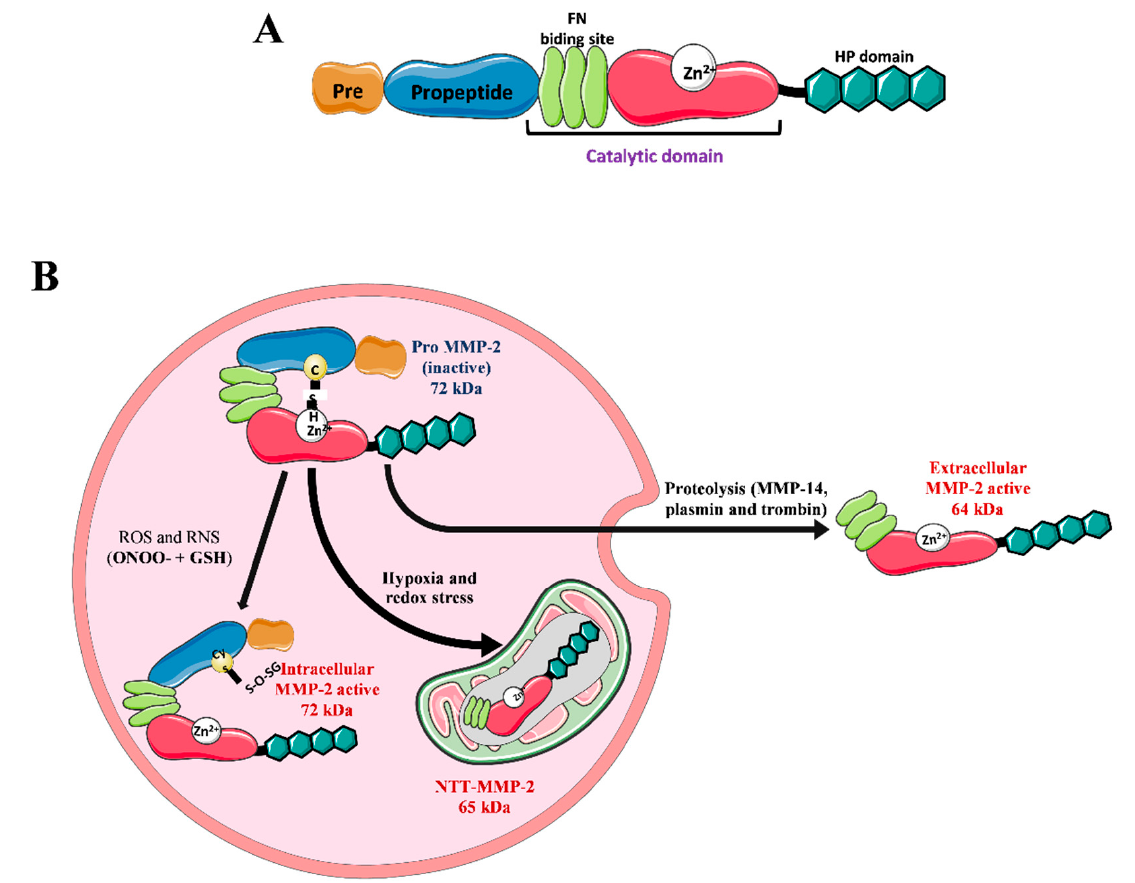
Figure 2. Structure, activation and isoforms of MMP-2. ( A ) MMP-2 has in its structure a signal peptide (Pre), a propeptide (Pro), a catalytic domain (having a zinc ion and three fibronectin repeats that confer affinity to collagen) and hemopexin (HP). ( B ) The inactive isoform of MMP-2 has a molecular size of 72 kDa (pro-MMP-2). Inactivity is guaranteed by a cysteine residue in the propeptide domain, which binds to Zn 2+ in the catalytic domain, preventing the binding and proteolysis of substrates. The active intracellular isoform of MMP-2 has a molecular size of 72 kDa and occurs when ONOO − or GSH reacts with ONOO − . The reaction product binds to the cysteine residue of the propeptide, which prevents it from complexing with the Zn 2+ atom in the catalytic domain, allowing the catalytic domain to interact with substrates. The 65 kDa NTT-MMP-2 is constitutively active, formed under conditions of hypoxia and oxidative stress, and leads to activation of alternative MMP-2 promoters that do not translate the first 77 amino acids. This isoform is not secreted into the extracellular environment, found in mitochondria and cytosol. The extracellular isoform of MMP-2 with a molecular size of 72 kDa, activated by the proteolytic removal of the propeptide domain by MMP-14, thrombin and plasmin, produces an active isoform of 64 kDa. FN: fibronectin GSH: reduced glutathione; ONOO − : peroxynitrite; ROS: reactive oxygen species; RNS: reactive nitrogen species; NTT-MMP-2: truncated N-terminal isoform of MMP-2; image elements from smart.server.com. MMP-2 is encoded by a 27-kb gene that has 13 exons and 12 introns located on chromosome 16. The gene has consensus sequences for the transcription factors AP-2 and SpI [31]. The gene is transcribed into a 3.1-kb mRNA [32], which is translated into a 660-residue protein that contains a 29-residue signal peptide. This peptide is responsible for translocating MMP-2 to the endoplasmic reticulum, followed by secretion into the extracellular medium, giving rise to a latent enzyme of about 72 kDa [29,33] (Figure 2). The absence of catalytic activity of the enzyme is maintained by the interaction between a sulfhydryl bond between a cysteine residue present in the pro-peptide and zinc at the catalytic site [34]. In the enzymatic activation, the catalytic site is exposed, which